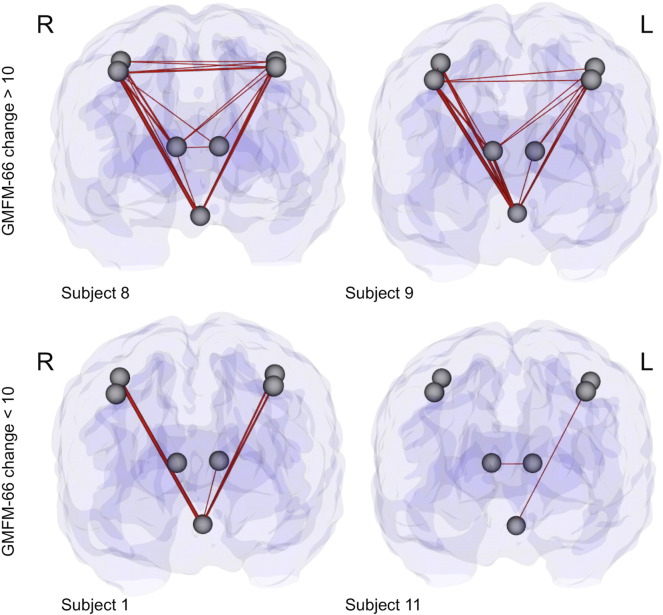
The distribution of connectivity increases over a 2-year period within the sensorimotor system for four representative subjects. To generate these connectome maps, the change in each edge was normalized by the total WM volume to minimize the effect of age-related brain volume growth. The gray spheres represent the nodes, and the tubes between the nodes represent positive changes in edges over a 2-year period, with their thicknesses proportional to the magnitudes of the changes.